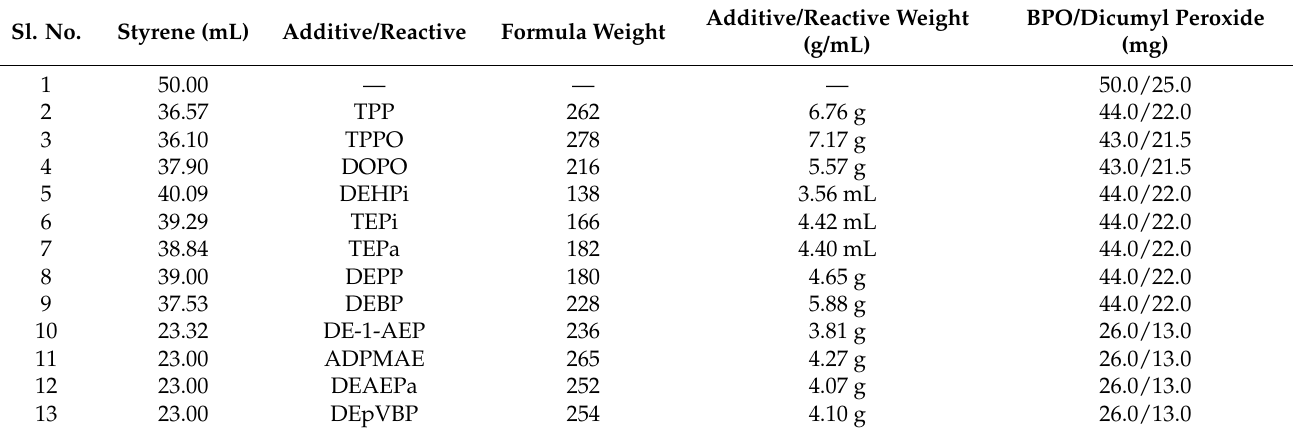
Table 1. Details of the preparative data for St-based bulk polymers